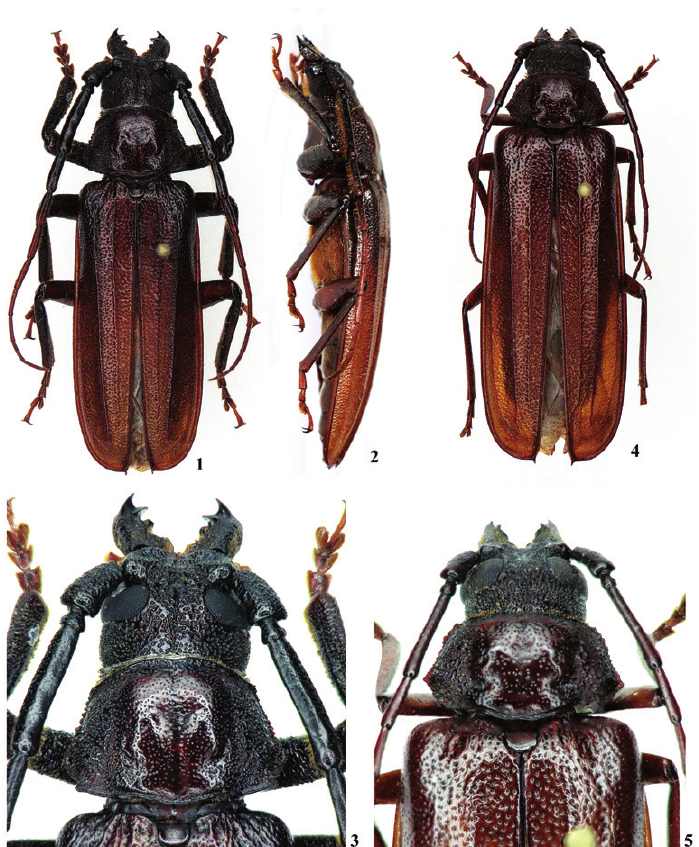
Figures 1–5. Seticeros tunupai sp. n. : 1 holotype male, habitus, dorsal 2 idem, lateral 3 idem, head and pronotum, dorsal 4 paratype female, habitus, dorsal 5 idem, head and pronotum,